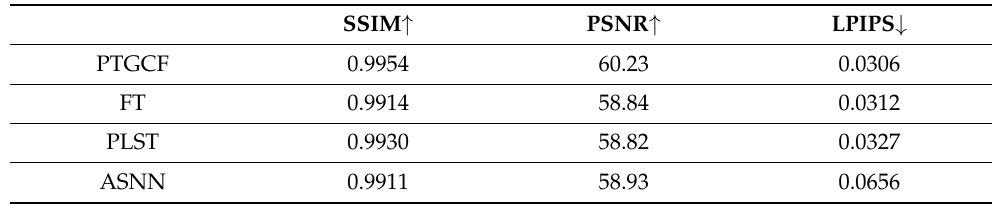
Table 3. Quantitative results of different methods in terms of SSIM/PSNR (higher is better) and LPIPS (lower is better).